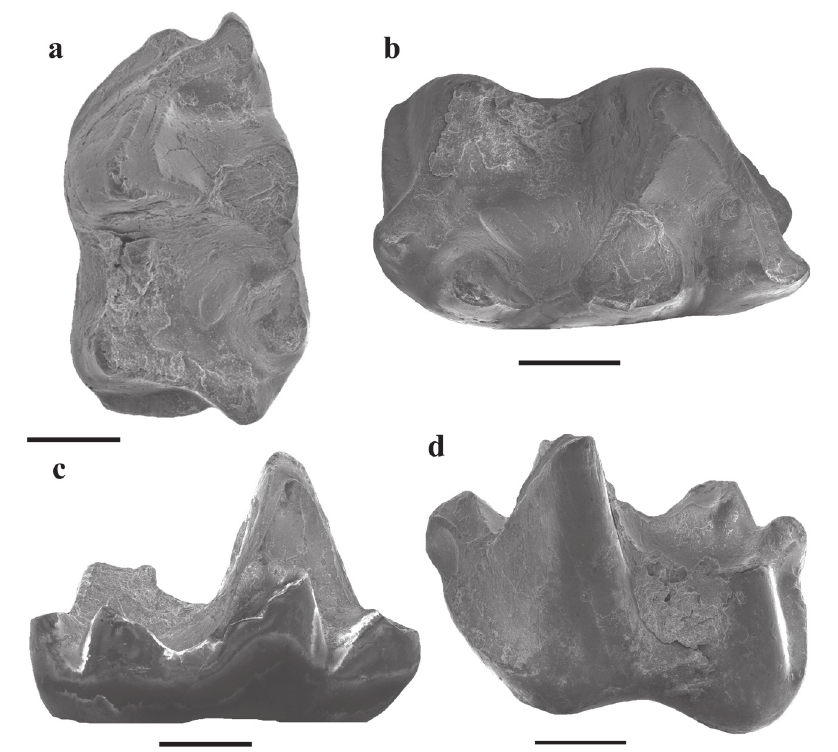
Figure 2 - type specimen of Bergqvistherium primigenia . SEM pictures of the type specimen of Bergqvistherium primigenia (MCt 4387-M), a left m3: a , occluso-labial; b , occlusal; c , lingual; d , labial views. Scale bar: 0,5